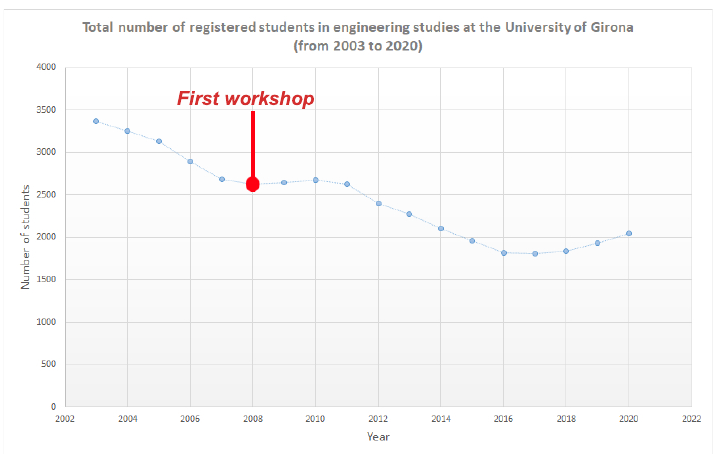
Figure 1. Engineering student annual registration at the University of Girona from 2003 to